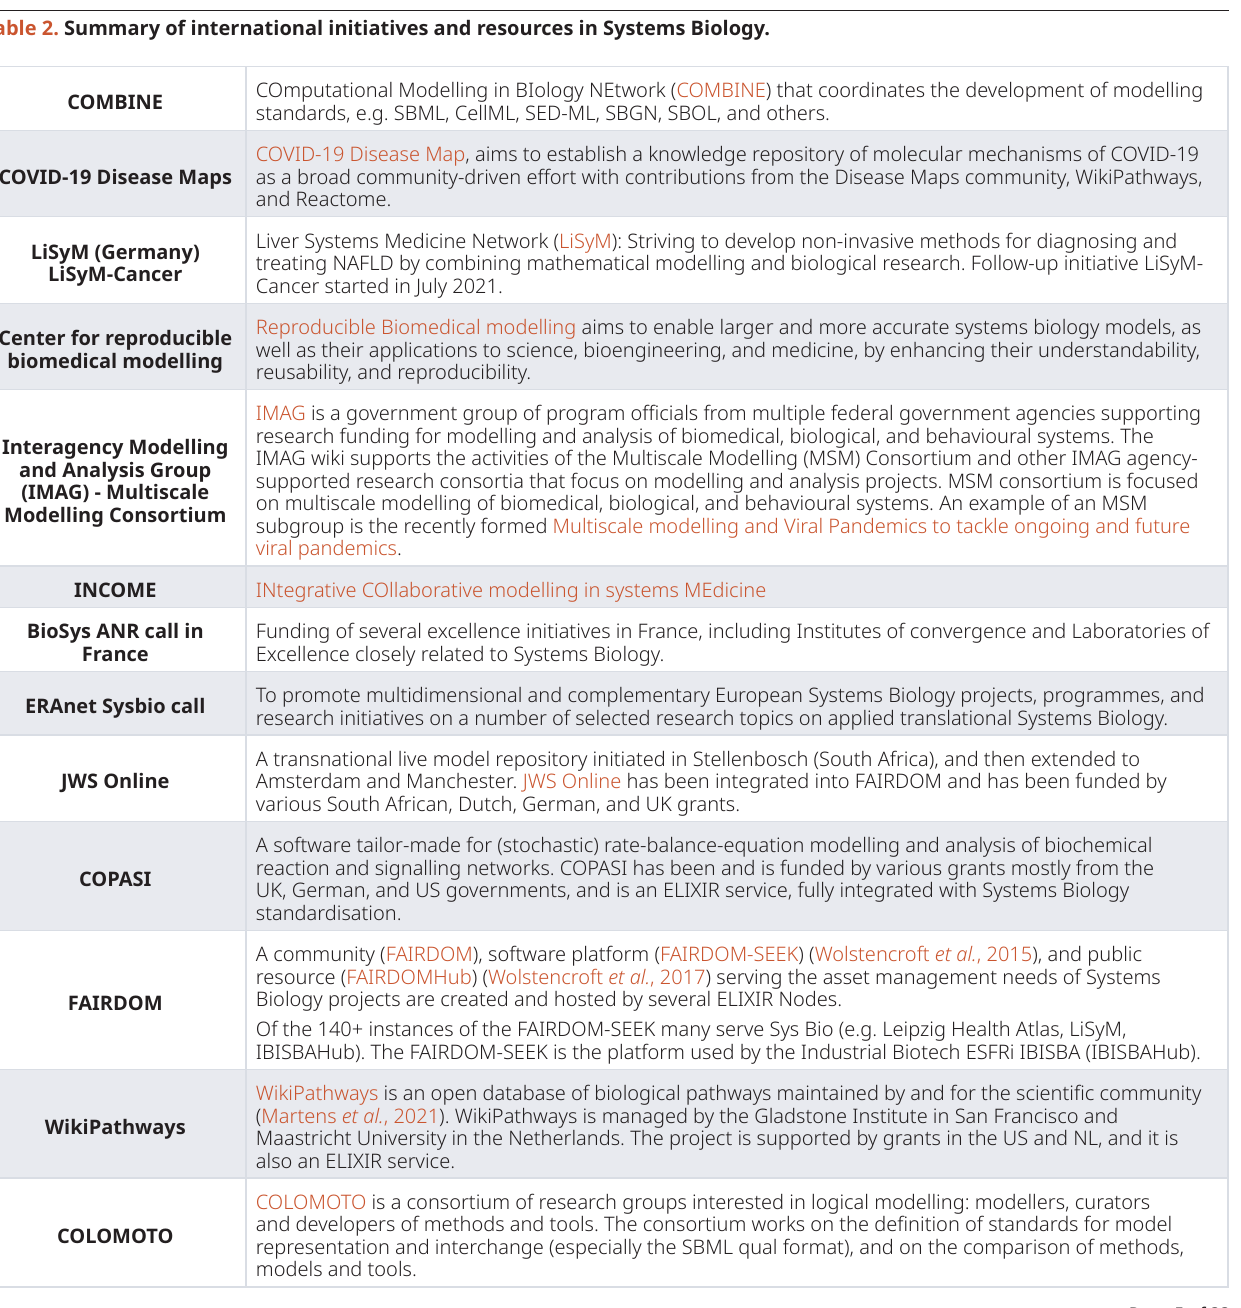
Table 2. Summary of international initiatives and resources in Systems